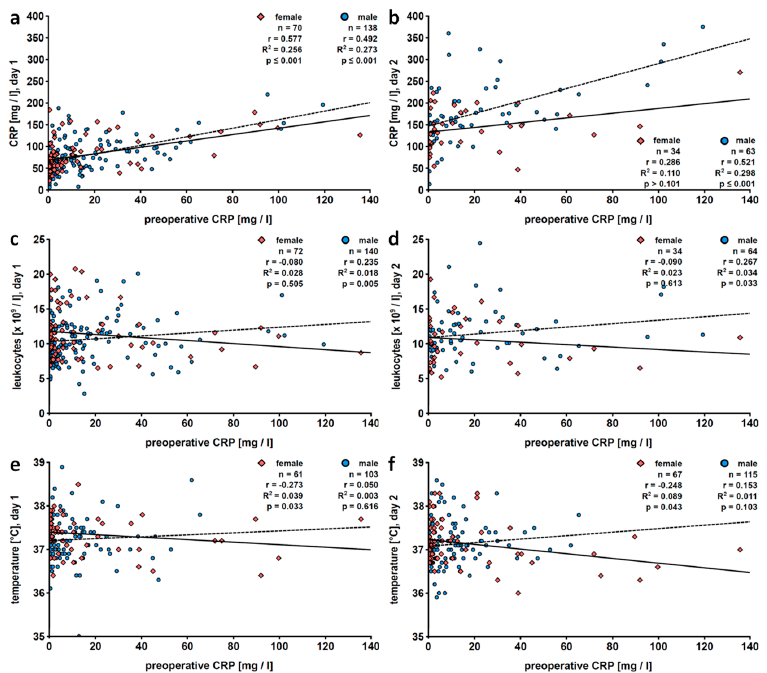
Figure 3. Patients stratified according to gender: linear regression analyses of preoperative levels of C-reactive protein (CRP) with postoperative CRP levels ( a , b ), blood leukocyte counts ( c , d ) or fever ( e , f ). Patients who underwent pulmonary resection were investigated retrospectively and data collected on the first ( a , c , e ) and the second ( b , d , f ) postoperative day are depicted. Preoperative CRP values were obtained within 7 days before surgery. The solid line represents the best fit line for data of female patients and the dashed line for those of male patients. r, correlation coe ffi cient; R 2 , coe ffi cient of